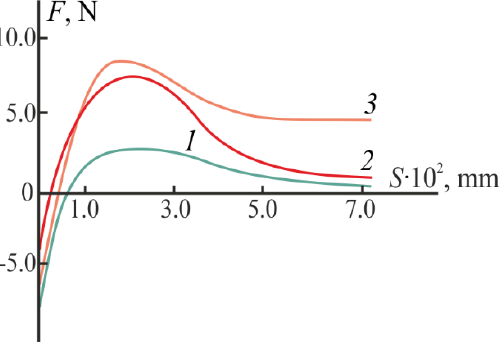
Figure 4. Force–distance dependence for the CS · HCl:Pl F-127 = 30:70 (vol./vol.) hydrogels with C CS · HCl = 3 wt.%, C Pl F-127 = 25 wt.% without ( 1 ) and with the addition of 3 wt.% D-AscA ( 2 ) and Metrogyl Denta™ ( 3